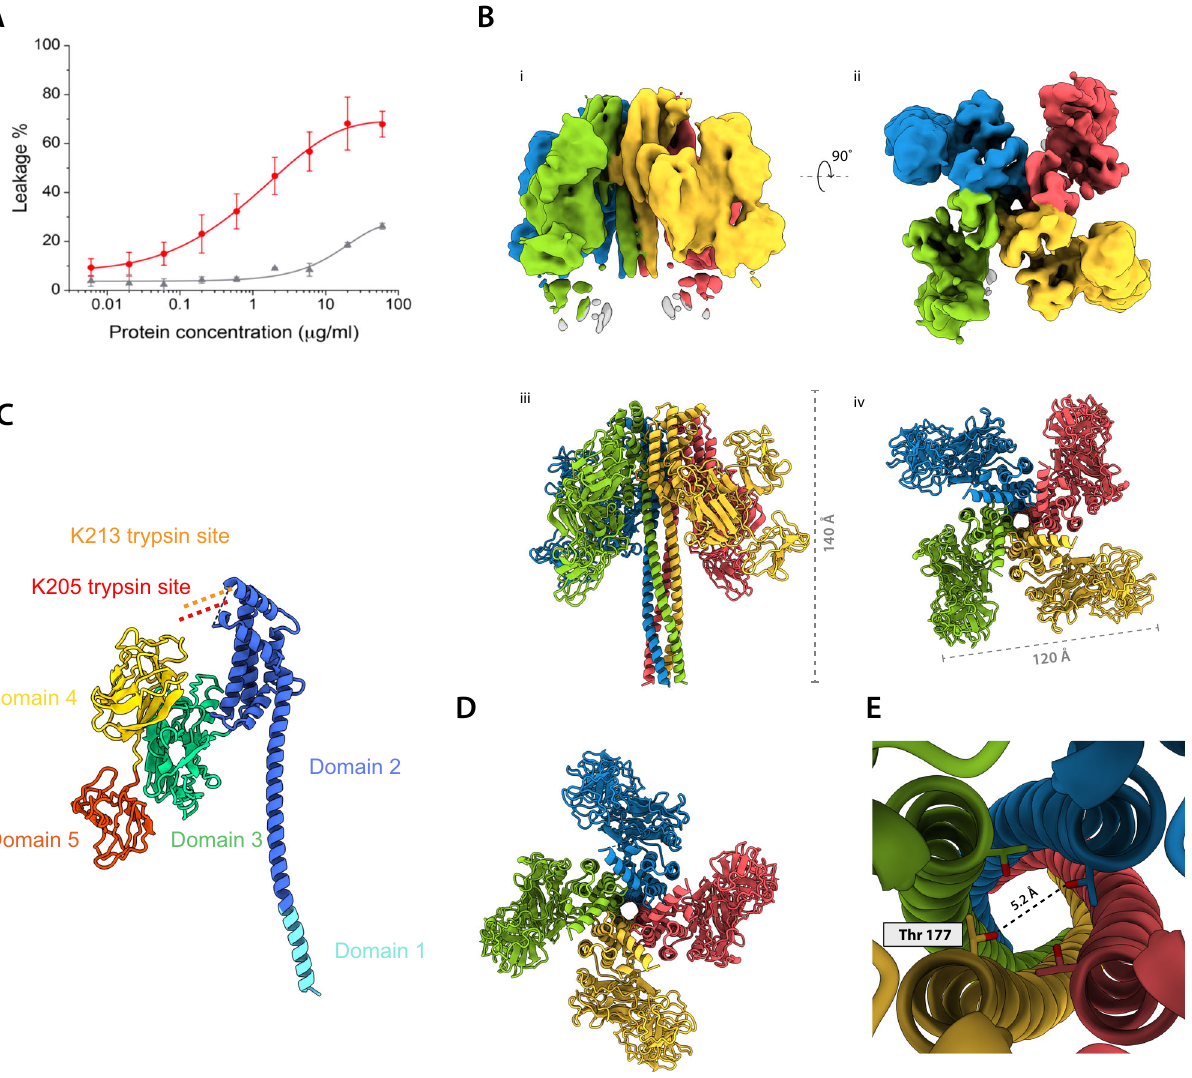
Fig. 2 Vip3Bc1 act has a greater propensity to perturb liposome membranes compared with Vip3Bc1. A Digestion of the complex increases activity according to CF dye release from LUVs upon addition of Vip3Bc1 act (red) and Vip3Bc1 (grey). Plotted data represents the mean and the error bars the standard deviation of the measurements from three independent replicates (Full data shown Supplementary Table 3 and 4). B Quaternary structure of Vip3Bc1 act tetramer as shown from two views of the complex related by 90° for the EM density (I, ii) and model (iii, iv). C Model of Vip3Bc1 act asymmetric unit, illustrating domain structure as a monomer. D Vip3Bc1 act tetrameric assembly as shown from the top conformation is consistent with a pore. E Pore structure of Vip3Bc1 act